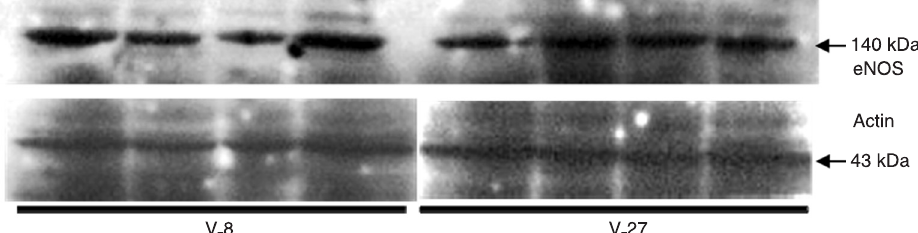
Figure 1. Semiquantitative immunoblotting of samples of right kidney from 4 rats of each group after 2 h of mechanical ventilation with tidal volumes of 8 mL/kg (V T 8) and 27 mL/kg (V T 27). Immunoblots that reacted with anti-eNOS antibodies revealed 140-kDa bands. eNOS = endothelial nitric oxide